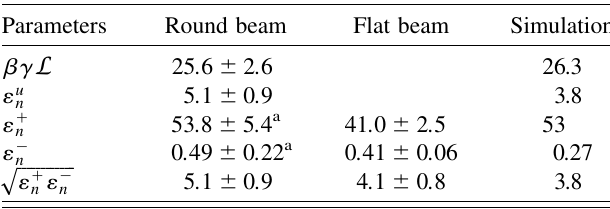
TABLE IV. Parameters measured from the angular-momen- tum-dominated round beam and the corresponding flat beam. Parameters Round beam Flat beam Simulation